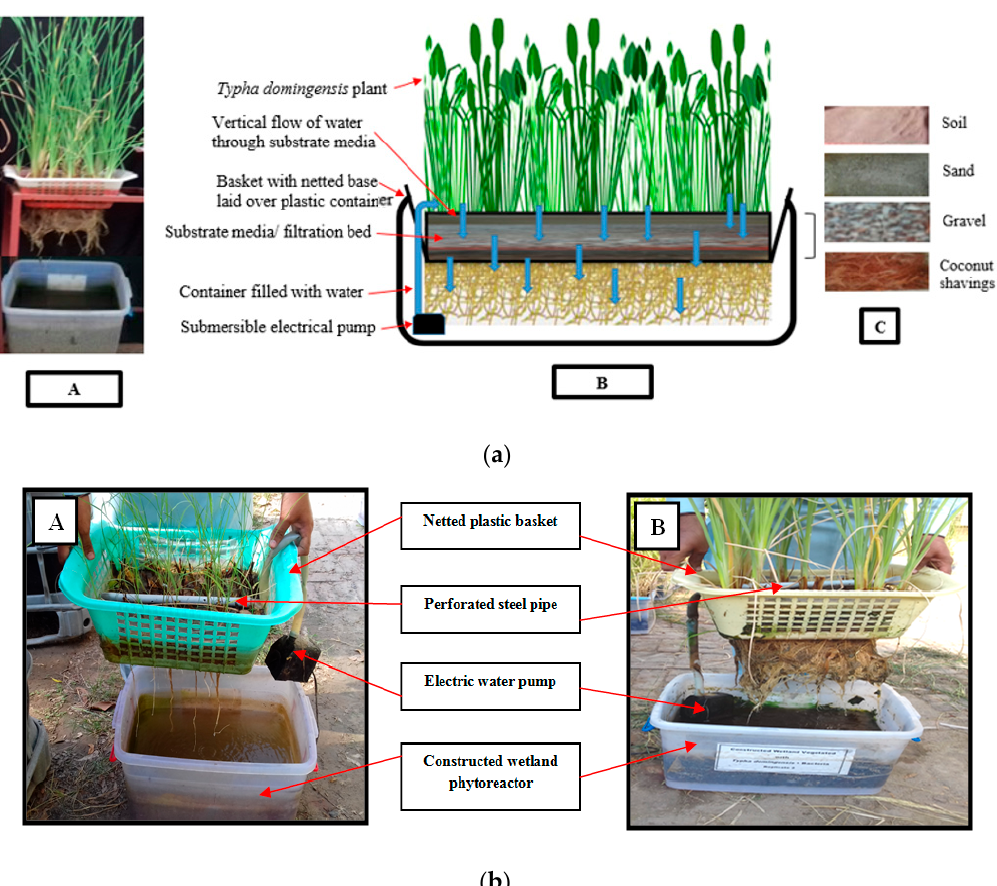
Figure 1. ( a ) Schematic diagram of a vertical flow constructed wetland phytoreactor. Photographic image of constructed wetland phytoreactor planted with Typha domingensis (A), configuration of constructed wetland showing vertical flow of water through filtration bed by electrical pump (B), and filtration media/substrate comprising soil, sand, gravel, and coconut shavings (C); ( b ) Vertical flow constructed wetland phytoreactors vegetated with Leptochloa fusca (A) and Typha domingensis (B) at different growth stages showing installation of an electric water pump for circulation of water by a perforated steel pipe through the wetland surface.